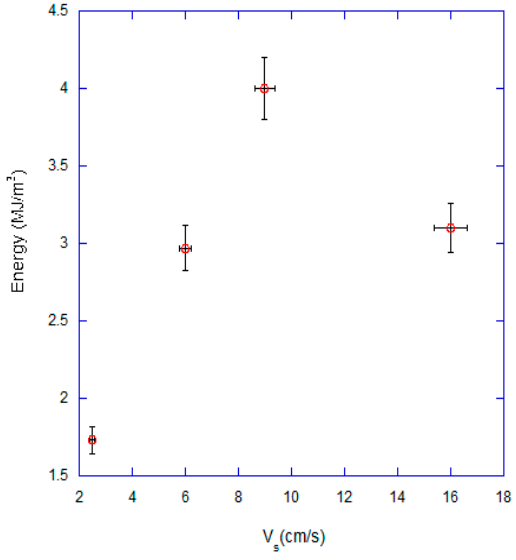
Figure 8. Effect of superficial velocity on energy content.